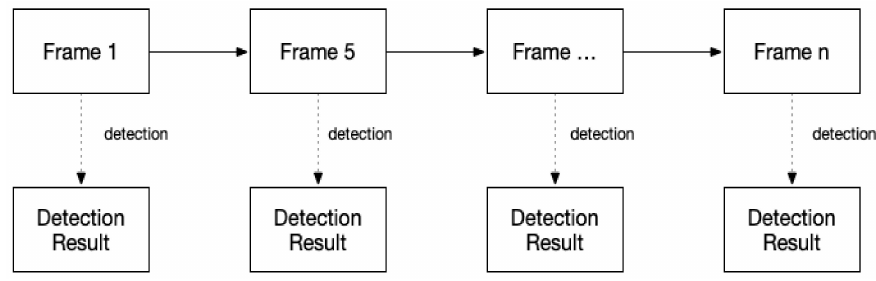
Figure 4. The process of vehicle